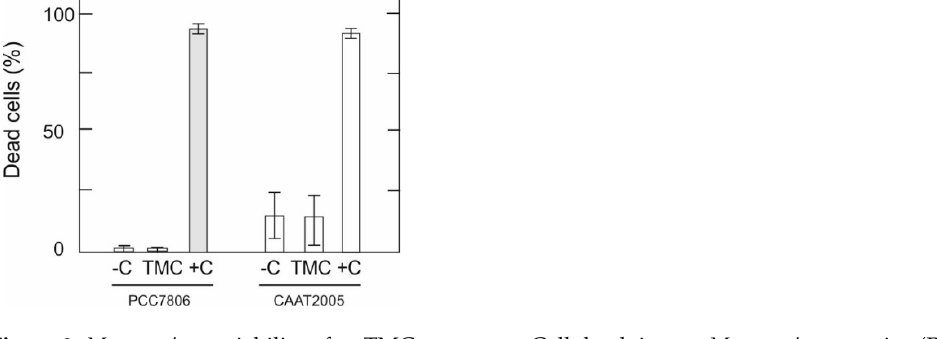
Figure 8. M. aeruginosa viability after TMC treatment. Cell death in two M. aeruginosa strains (PCC 7806 and CAAT2005 ‐ 3) was evaluated in cell pellets after TMC treatment. Cells were stained with SYTOX Green, examined, and counted under light and fluorescence microscopy. SYTOX ‐ positive cells were interpreted as being dead cells. Negative control ( − C, untreated cells) and positive control (+C, cells subjected to 70 °C for 10 min) were included.